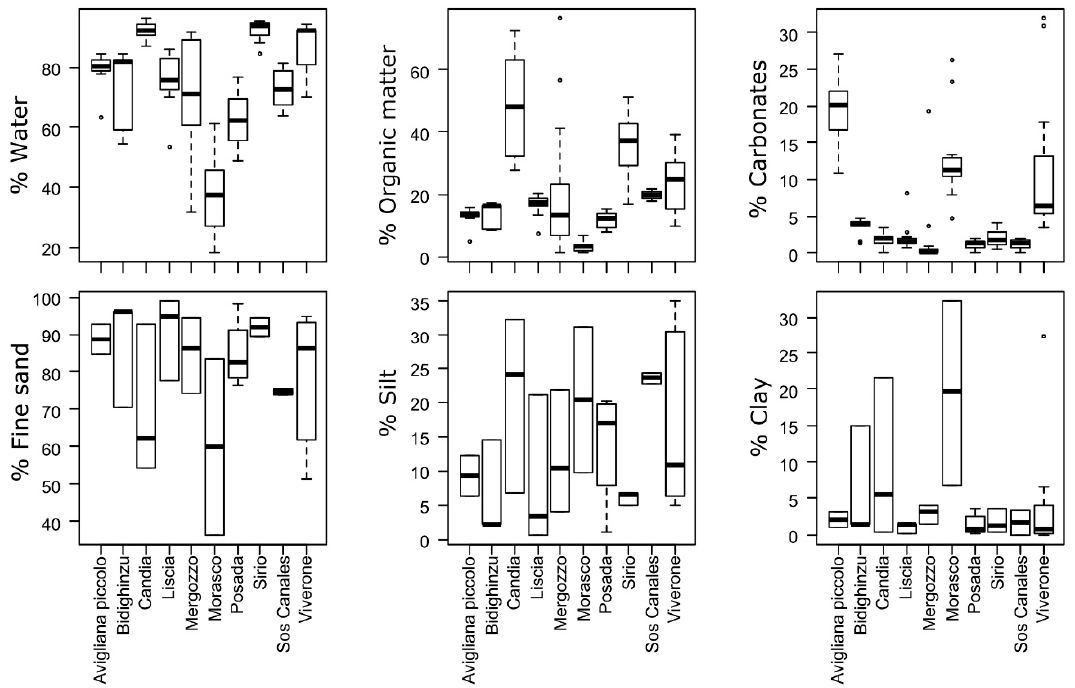
Figure 3. Distribution ofsediment chemical features (up: water, organic matter and carbonates contents) and soft sediment texture (down: fine sand, silt, clay) for each lake. All variables are reported as percentages.